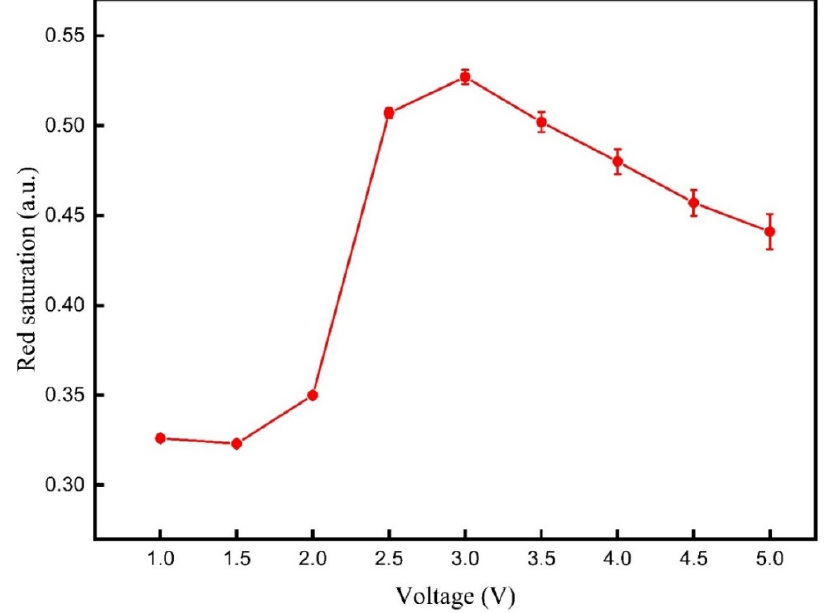
Figure 5. The red saturation of the three-color EPD when it was driven by different DC voltages. The red saturation increased with the increase of the DC voltage from 1 to 3 V. On the contrary, the red saturation decreased with the increase of the DC voltage from 3 to 5 V. The maximum red saturation was 0.527 when the DC voltage was 3